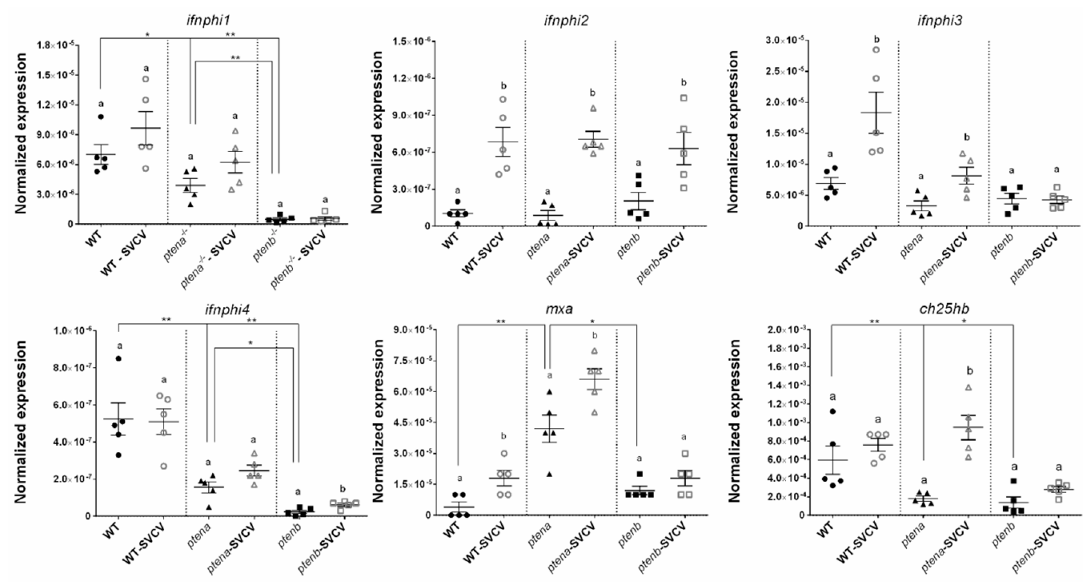
Figure 4. Expression of type I interferon (IFN)-related genes in wild-type (WT), ptena -/- , and ptenb -/- zebrafish larvae under healthy and SVCV-infected conditions. The expression of the different genes was normalized to the expression of the 18S ribosomal RNA gene. The graphs represent the means ± SEMs of 5 biological replicates. Statistically significant differences between the uninfected and SVCV-infected individuals from the same zebrafish line are represented with different letters, whereas differences among the zebrafish lines are represented with asterisks as follows: ** (0.001 < p < 0.01) or * (0.01 < p < 0.05).